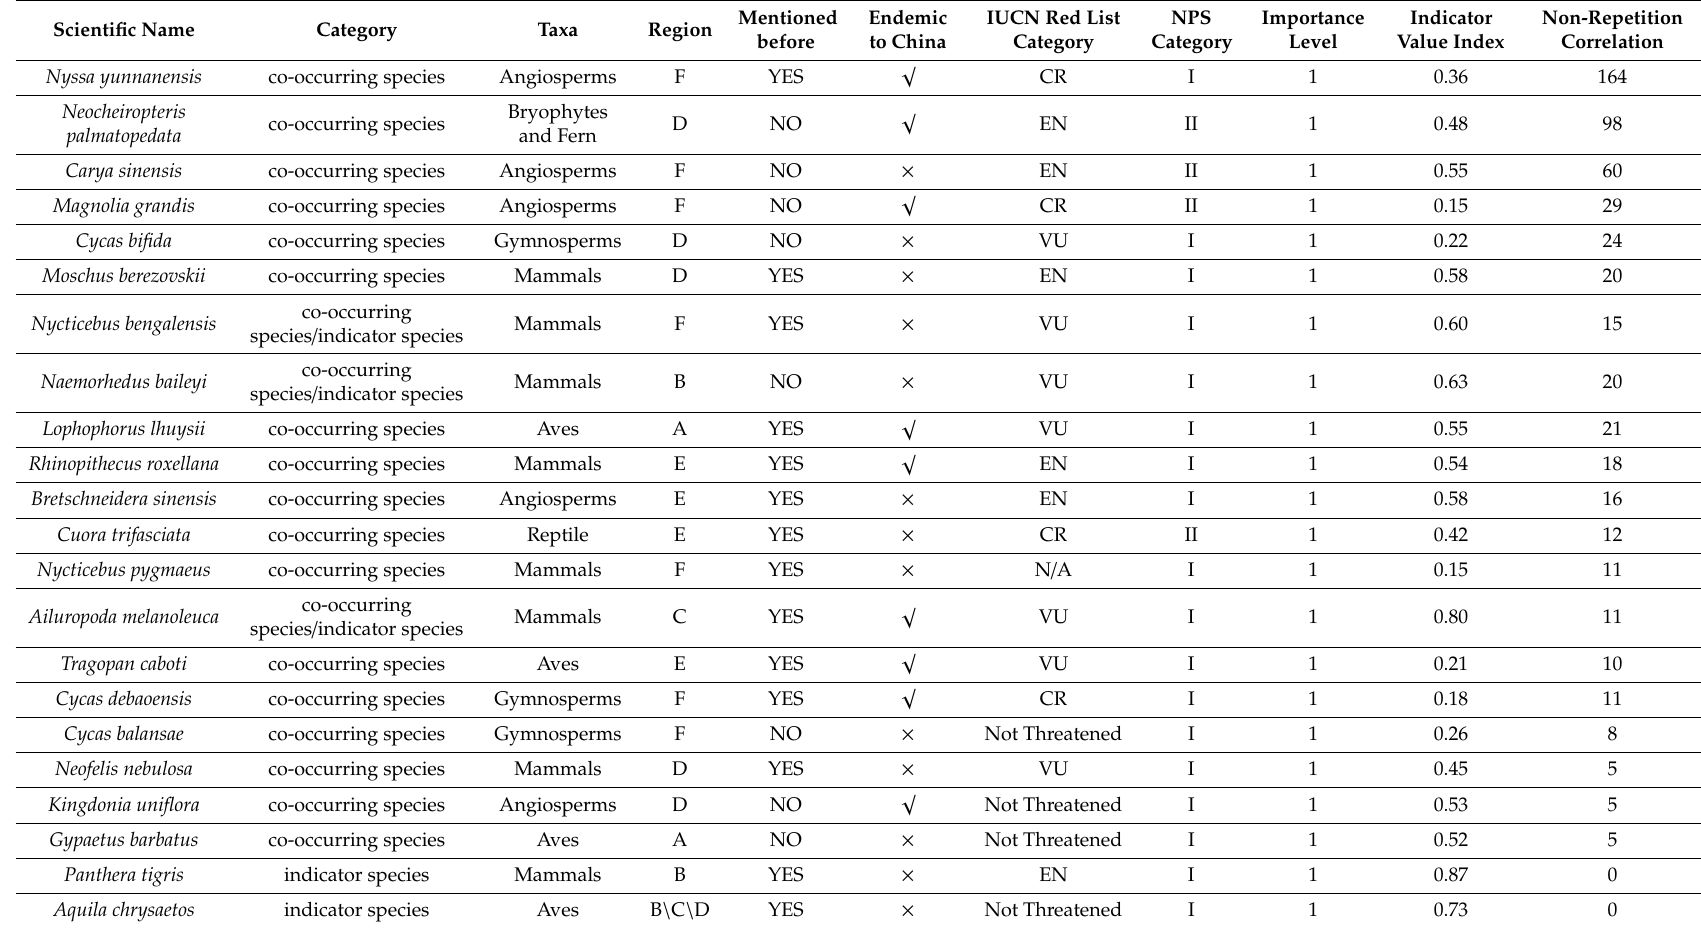
Table A2. List of umbrella species in Southwest